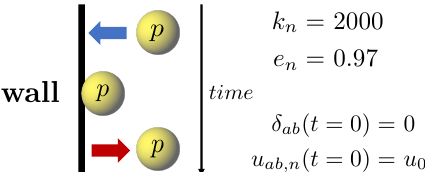
Figure 3. The simple test consists of a single particle colliding a wall in the normal direction. Only the collision force is accounted for and the parameters used for the resolution are visible on the right side. The contact starts at t = 0.